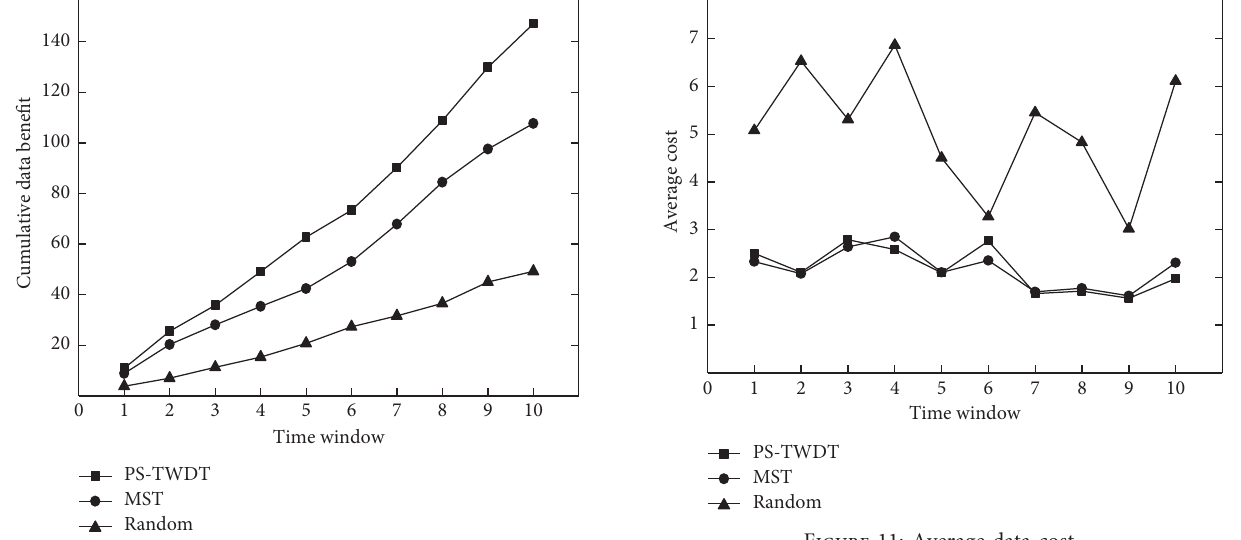
Figure 10: Cumulative data benefit.